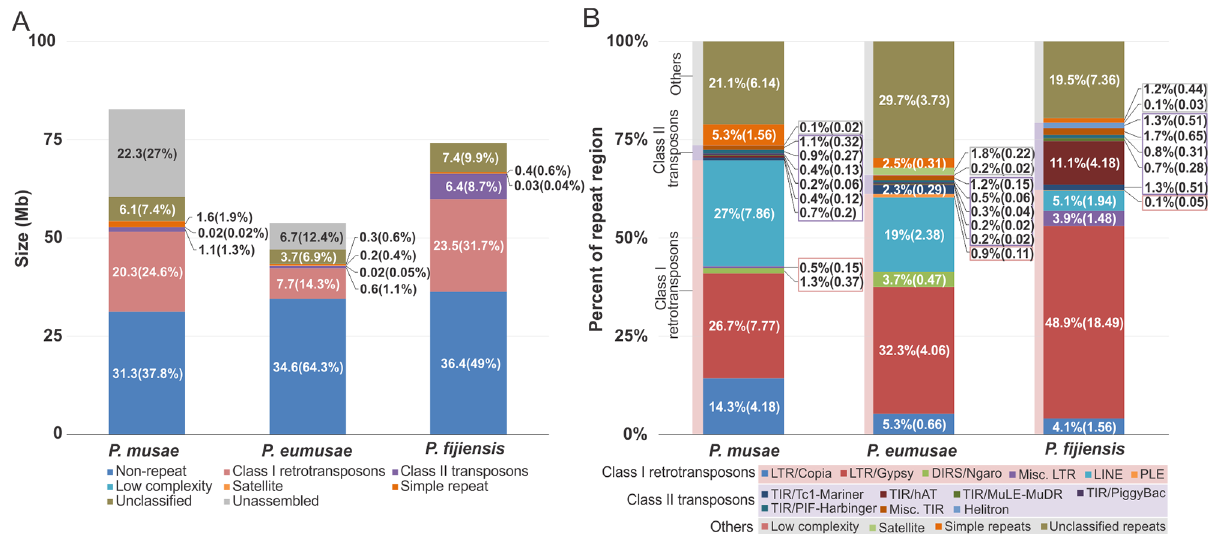
Fig 2. Genome size and composition in Pseudocercospora musae , Pseudocercospora eumusae , and Pseudocercospora fijiensis . (A) Overall genome composition and repeat content in P . musae , P . eumusae , and P . fijiensis . The size (Mb) and proportion (%) of the main components of the species ’ genomes are indicated. Given their close evolutionary relationships, the species show considerable differences in genome size mainly due to differences in repeat content. (B) The distribution and composition of repeat elements in P . musae , P . eumusae , and P . fijiensis . The proportion (%) and size (Mb) of each individual class of repeat elements are indicated. The three species differ in their composition and proportion of the different classes or repeat